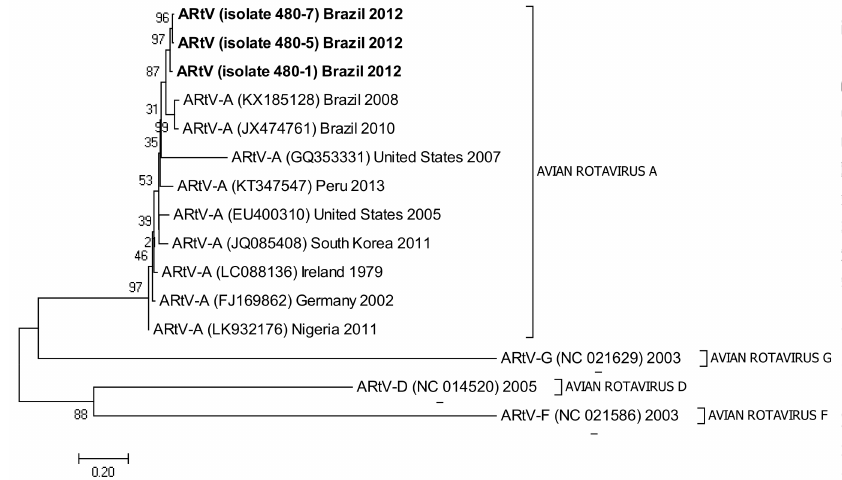
Figure 3. Phylogenetic tree for ARtV strains, was inferred with the neighbor-joining statistical method and based on the partial sequence of the NSP4 gene. Numbers along the branches refer to bootstrap values for 1000 replicates. Sequences of ARtV G, D, and F were used as out-group controls. Isolate 806-1 clustered with reference sequences of AReo from Hungary. The branch lengths and low bootstrap values from the common ancestor for reference sequences from Hungary, the United States, and China, all show the magnitude of the genetic change among different isolates from these countries (Figure 4).